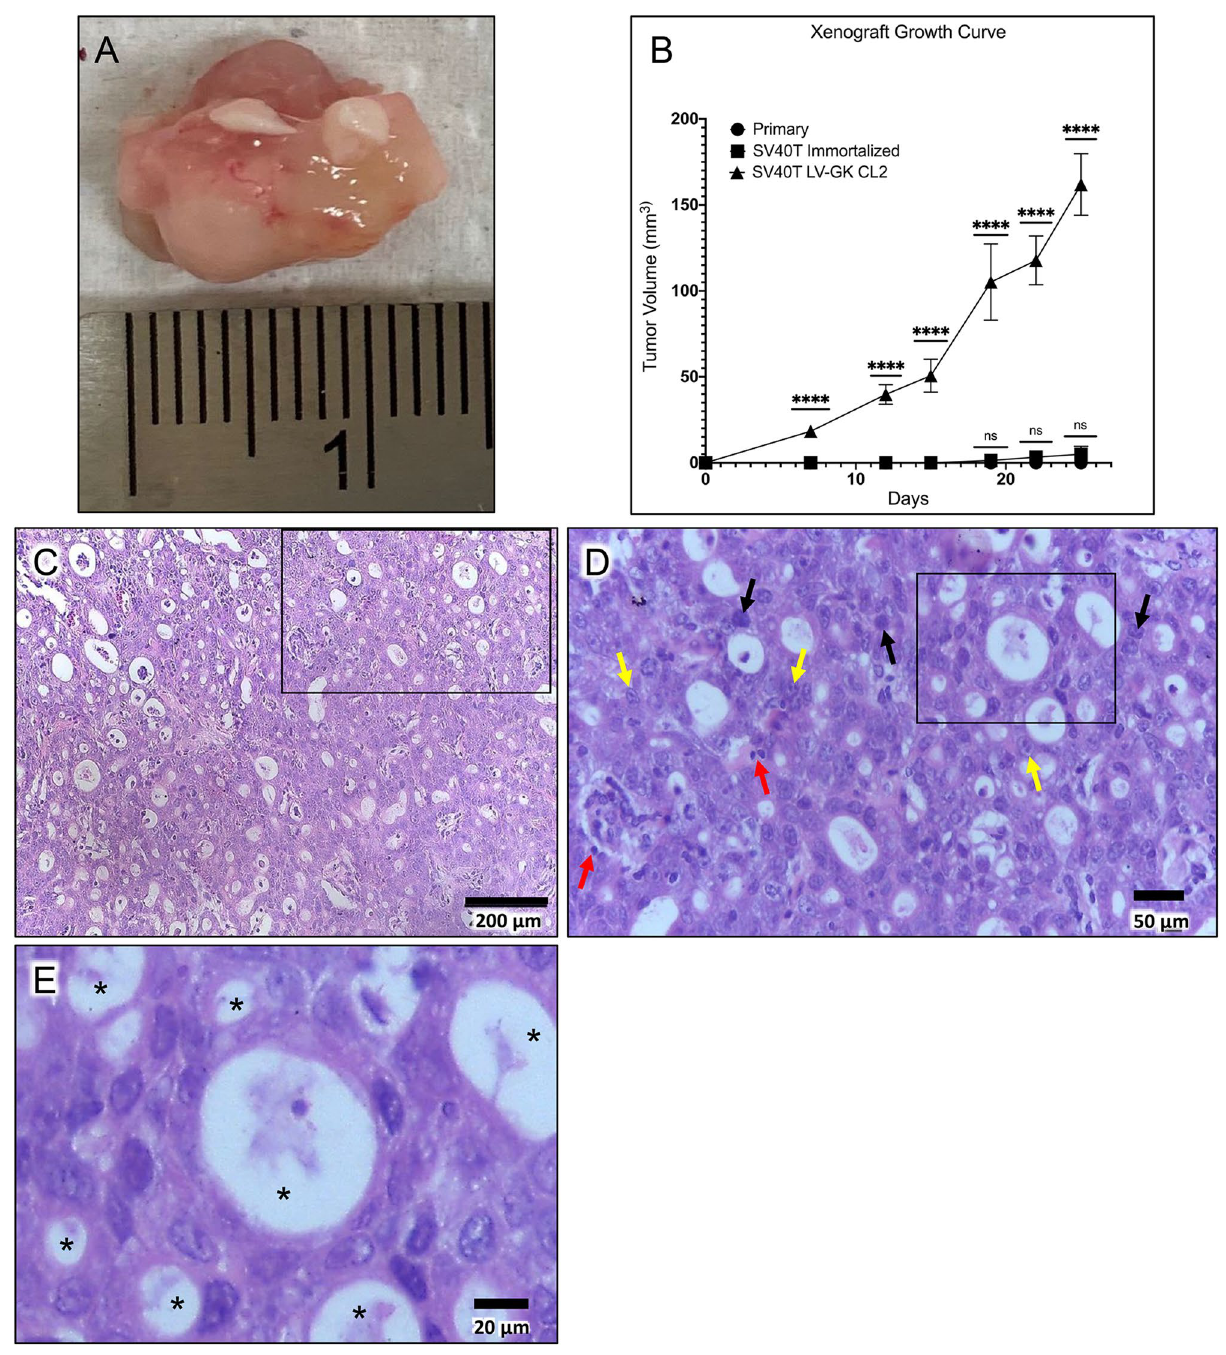
Figure 3. In vivo tumorigenesis assay. ( A ) Representative xenograft tumor explanted from a nude mouse 42 days after subcutaneous injection of transformed epithelial cells (SV40T LV-GK CL2). ( B ) Comparison of xenograft tumor volume between primary epithelial cells versus the SV40T immortalized and SV40T LV-GK CL2 cell lines; ****p < 0.0001; ns = not significant (p ≥ 0.05). ( C ) H&E microscopic image of xenograft tumor. ( D ) Higher power H&E image; region of interest box shown in panel C. Black arrows = hyperchromatic nuclei; yellow arrows = nuclei with large nucleoli; red arrows = pyknotic nuclei. ( E ) Higher power H&E image; region of interest box shown in panel D. *Asterisks indicate lumen of gland-like structures lined with ductal-like cells; lumen were filled with mucin in the Alcian blue staining (Fig.